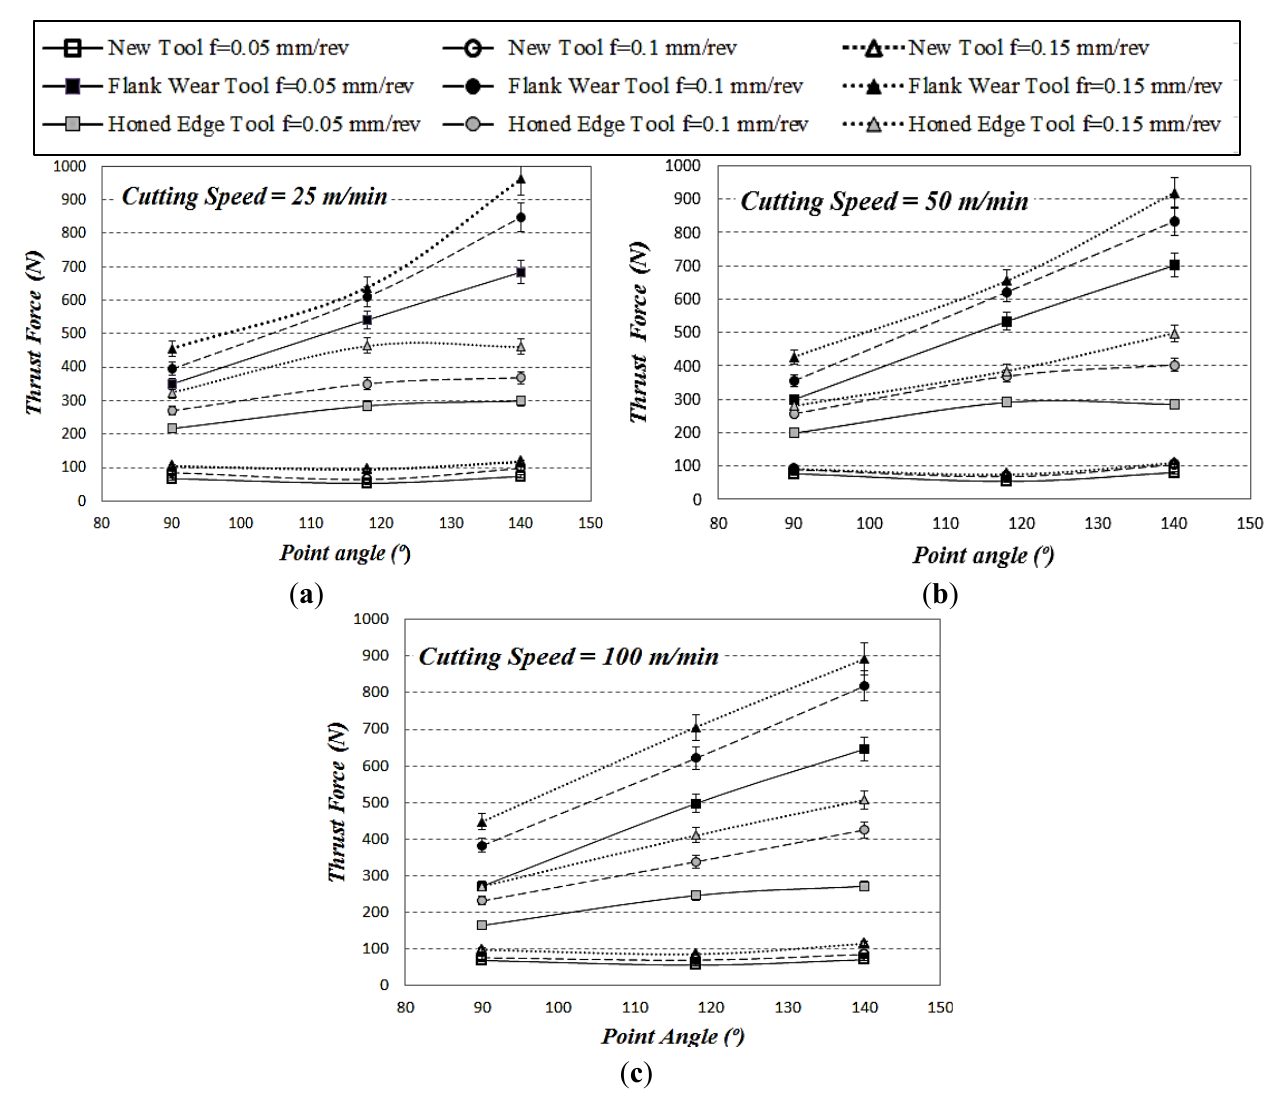
Figure 4. Thrust force for three point angles at different cutting speeds (measurement variations are indicated including error bars): ( a ) cutting speed 25 m/min; ( b ) cutting speed 50 m/min; and ( c ) cutting speed 100